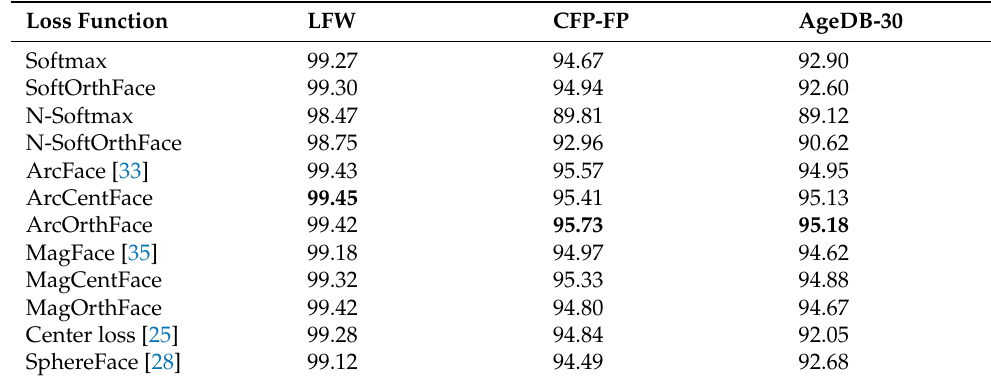
Table 3. Verification Accuracy (%) on Several Benchmarks with Various Loss